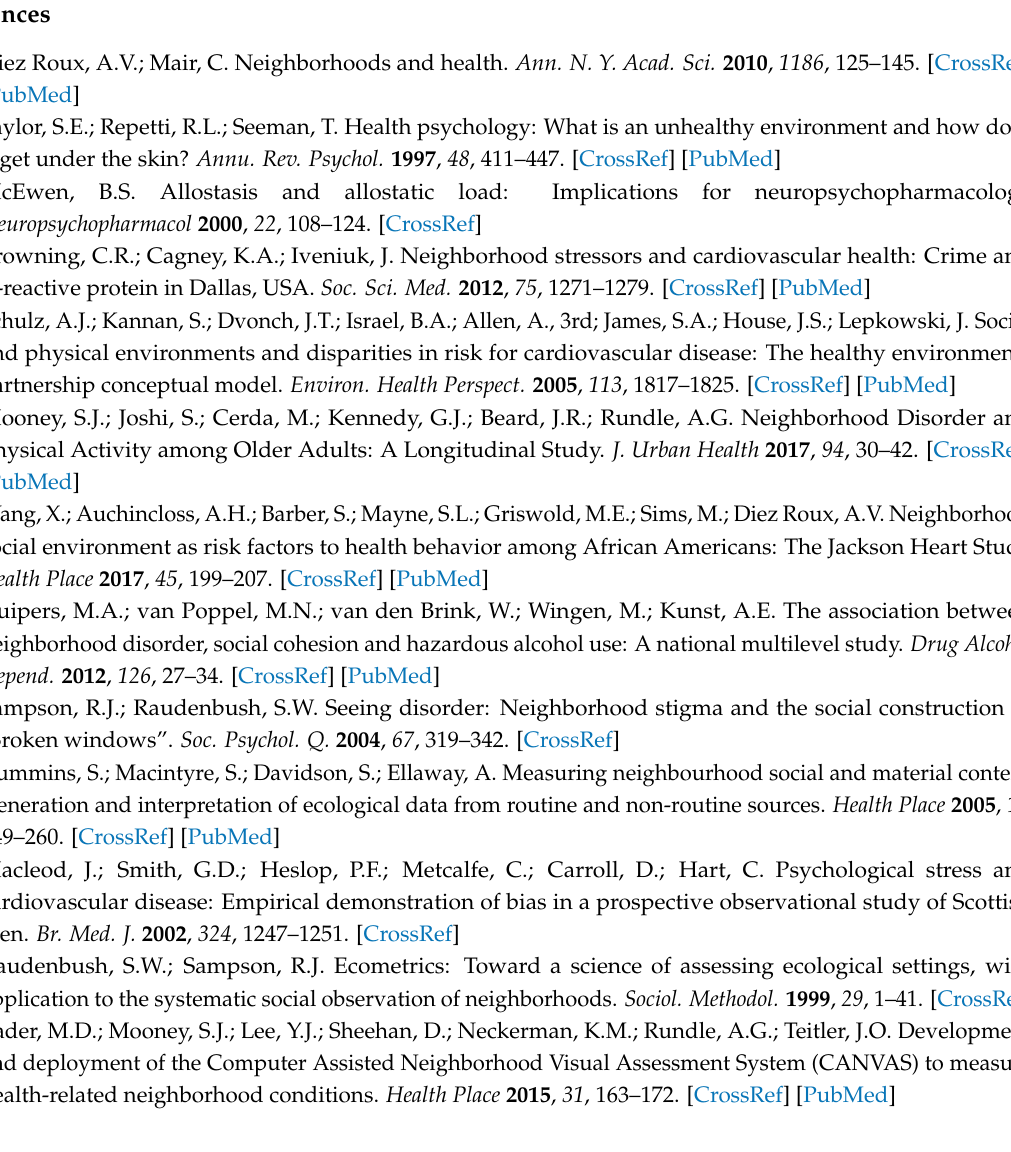
s1, Table S1: Associations of Neighborhood Physical Disorder with Obesity-Related Outcomes 1 Excluding 2 Participants for Whom All Google Street View Imagery was Earlier Than 2015 ( n = 223